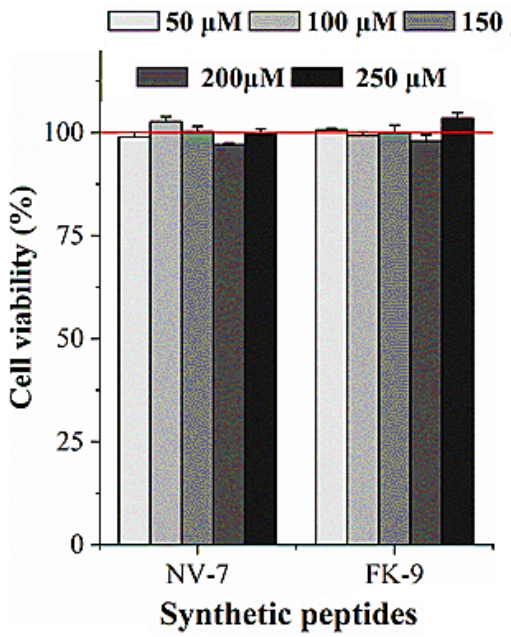
Figure 4. Effect of synthetic peptides on HepG2 viability.